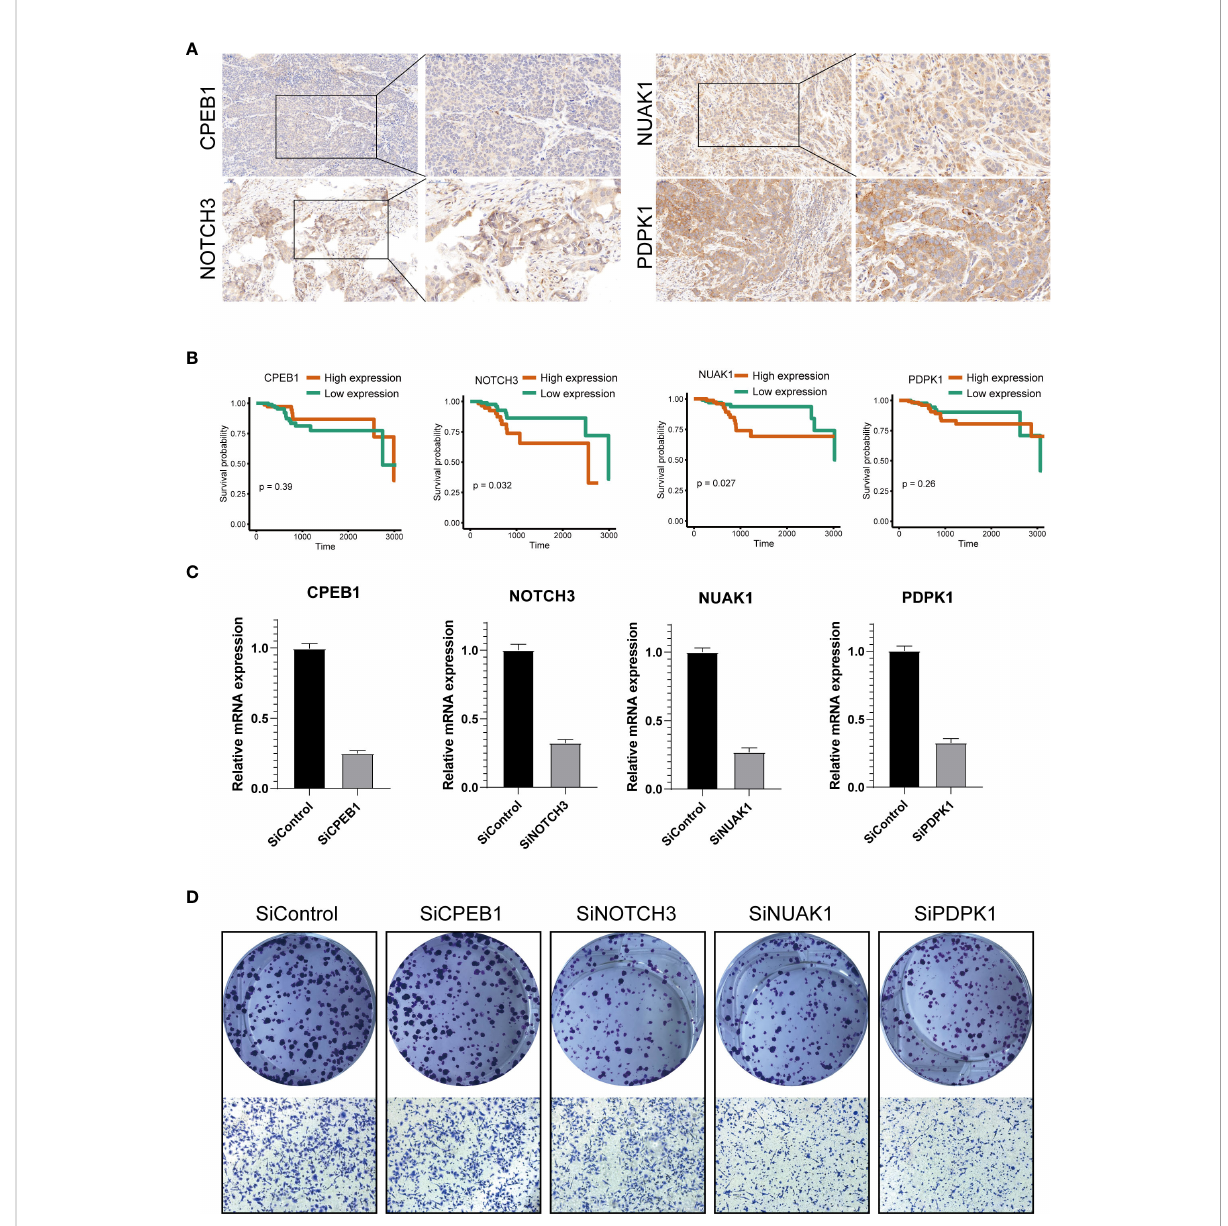
FIGURE 10 Validation of the four prognostic genes by functional analysis. (A) Immunohistochemistry analysis of CPEB1 , NOTCH3 , NUAK1 , and PDPK1 in breast cancer tissues. (B) The high expression levels of NOTCH3 and NUAK1 were associated with a poor prognosis. The Cox proportion hazards model was used to understand the signi fi cance between the two groups. Tissue microarray was obtained from Alenabio Technology Co., Ltd., Xian, China. The tissue microarray contained 138 breast cancer specimens. (C) siRNA knockdown ef fi ciencies. (D) The colony formation and migration analysis of breast cancer cell depletion with CPEB1 , NOTCH3 , NUAK1 , and PDPK1